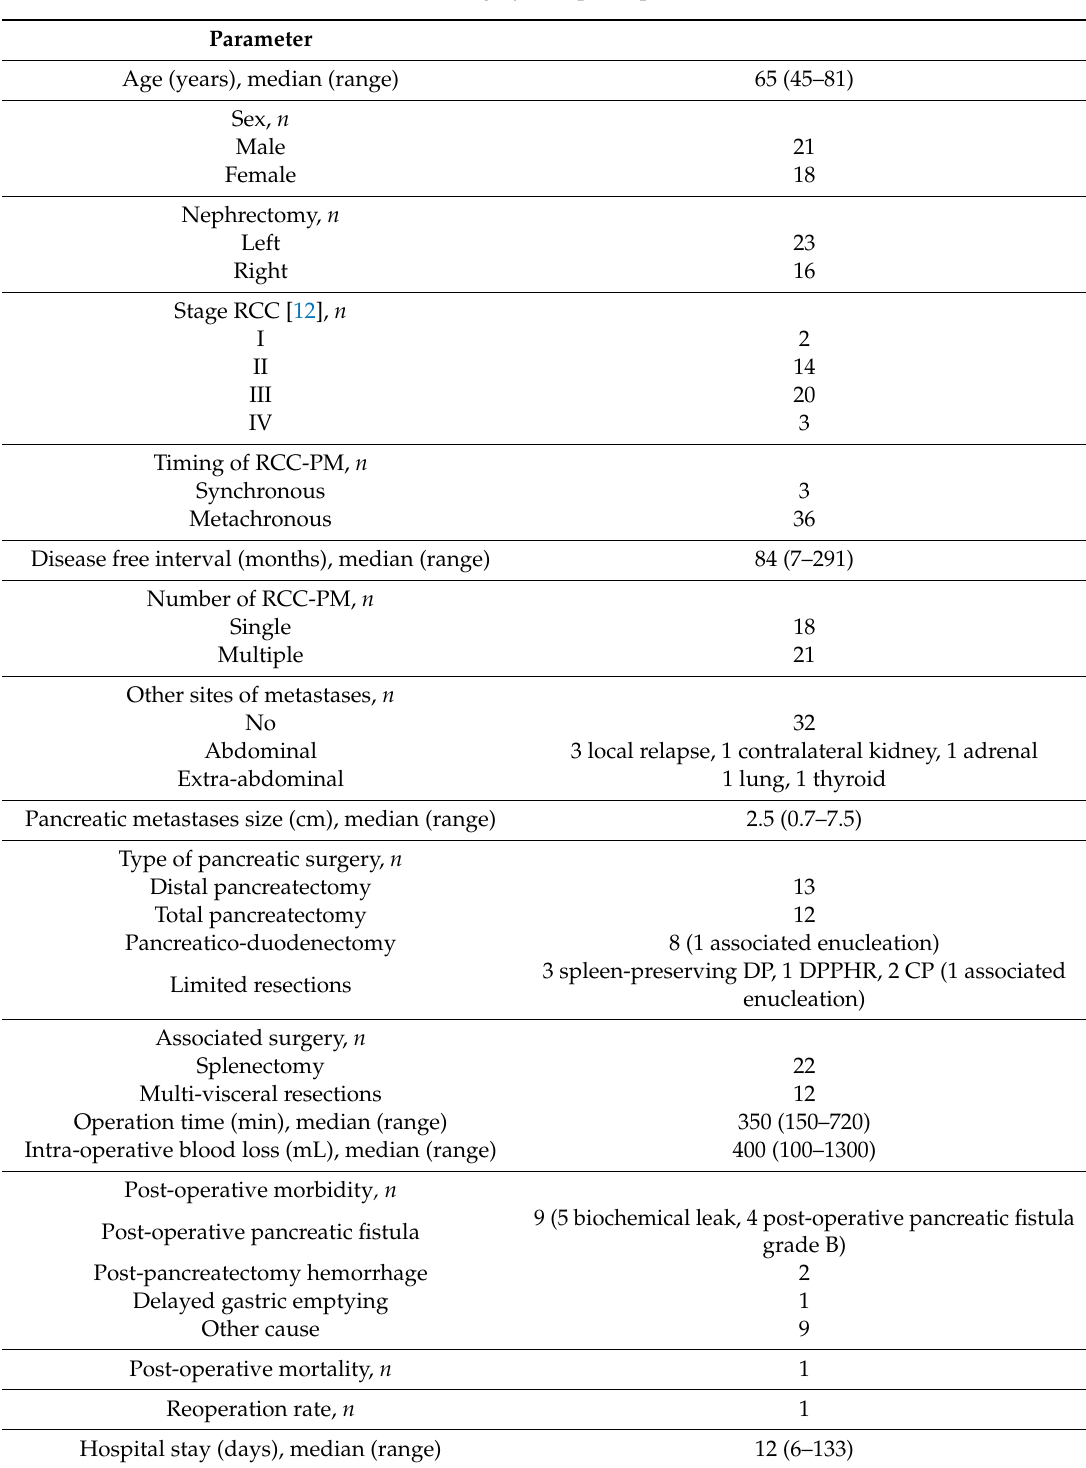
Table 1. Clinical features, surgery, and post-operative outcome ( n =